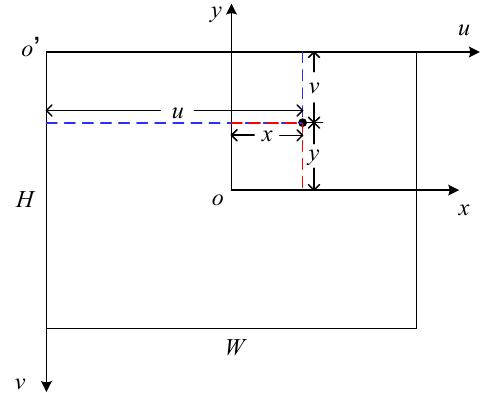
Figure 3. The sketch map of the relation between image coordinate system and pixel coordinate system.